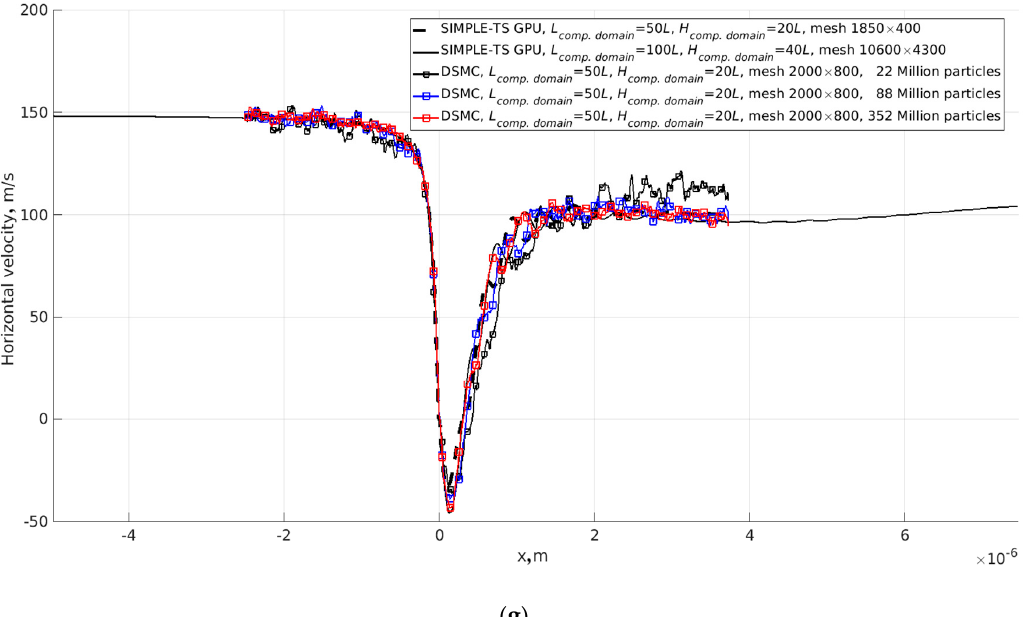
Figure 2. ( a ) Macroscopic field of horizontal velocity; ( b ) SIMPLE-TS staggered grid with 10,600 × 4300 cells; ( c ) zoomed-in SIMPLE-TS staggered grid with 10,600 × 4300 cells around cantilever; ( d ) mesh near cantilever of DSMC; ( e ) zoomed-in mesh near cantilever of DSMC around cantilever; ( f ) application of TAS in basic cells; and ( g ) horizontal velocity profiles at center of flat plate along x -axis. Profiles were obtained by SIMPLE-TS GPU (continuum model) and DSMC.